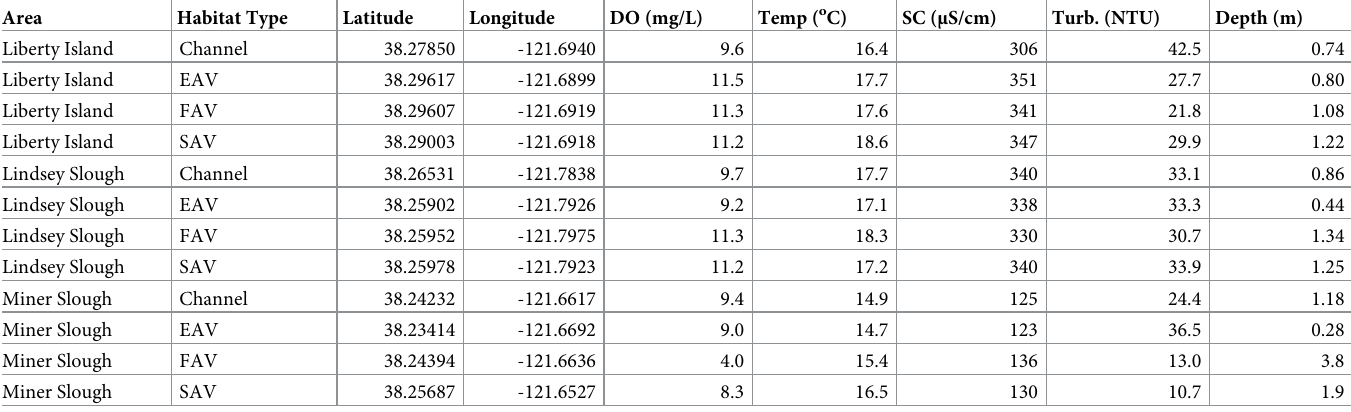
Table 1. Sampling stations and habitat types, with average environmental parameters when samples were collected. DO = dissolved oxygen in milligrams per liter, Temp = surface temperature in degrees Celsius, SC = specific conductance in micro-Siemens per centimeter, Turb. = Turbidity in nephelometric turbidity units, and Depth of water in meters. Latitude and Longitude are in WGS